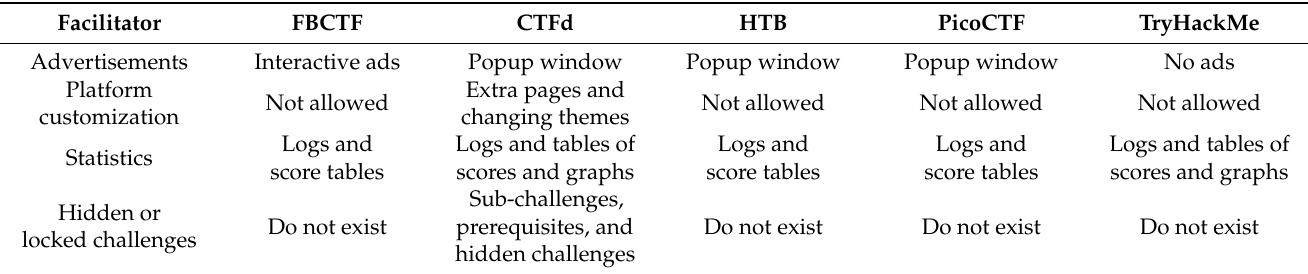
Table 2. Evaluation analysis of the facilitator’s criteria.